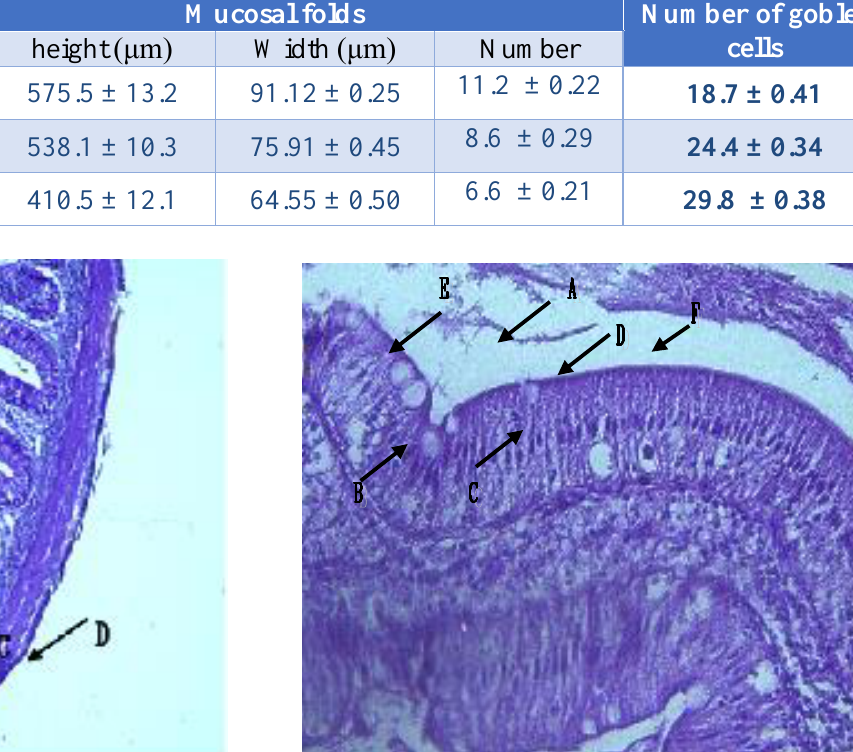
Table,1: The mean height and width of mucosal folds (μm), their number in per microscopic field (X100) and number of goblet cells in each fold, in intestine of common carp (Mean ± S.E).